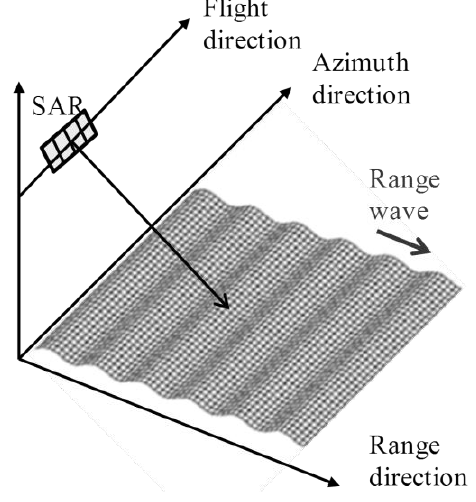
Figure 11. Illustration of range traveling regular wave in Bragg resonant